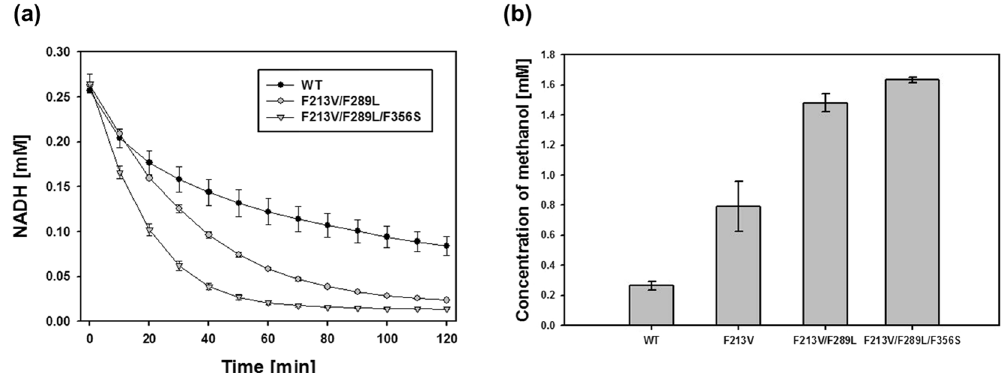
Figure 3. Formaldehyde reduction activity of MDH variants. ( a ) Concentration of the cofactor NADH during the reduction reaction. WT, wild type MDH. ( b ) After reduction by each MDH variant for 1 h at 50 °C, methanol levels were measured by HPLC. The data represent the mean value of three independent